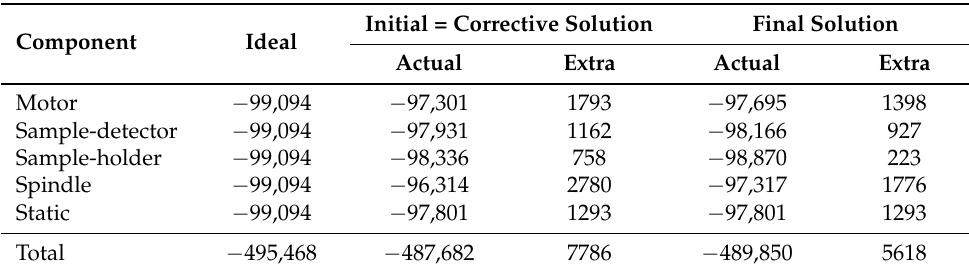
Table 12. KPIs (EUR/year) yielded from training the model for the friction welding machine (HWH). Component